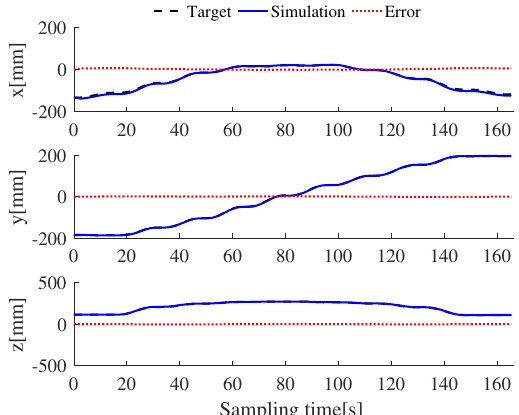
Figure 12. The change in the space coordinates of the endpoints.